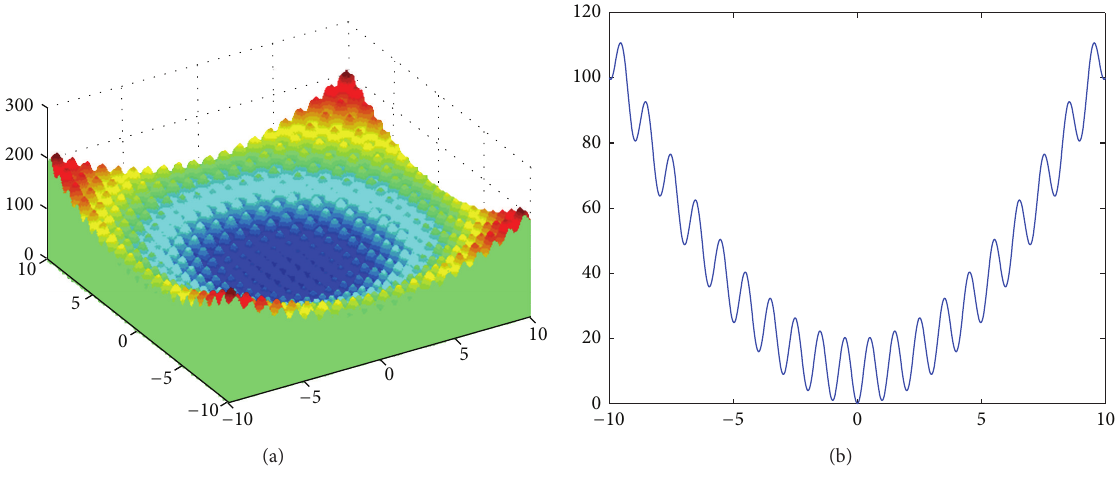
Figure 4: The Rastrigin function: (a) 𝑛 = 2 , (b) 𝑛 = 1 .